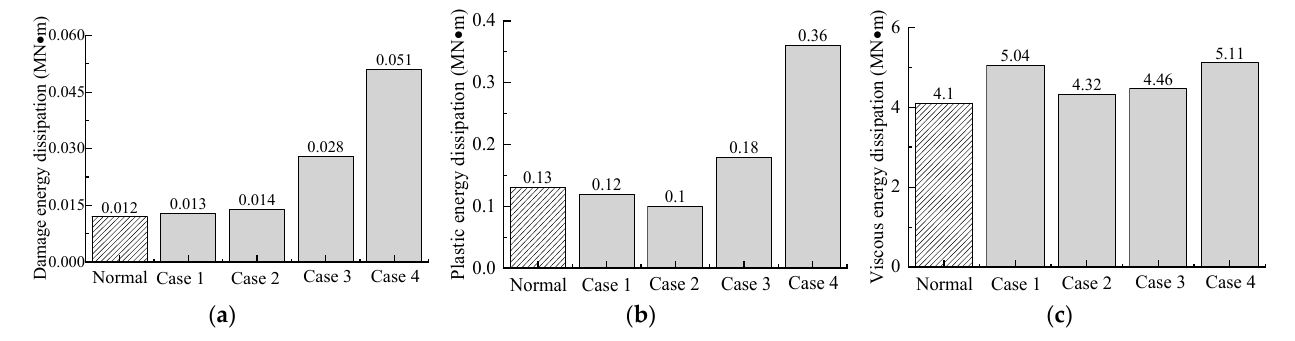
Figure 15. Comparison of the energy dissipation in different cases. ( a ) Damage energy dissipation; ( b ) plastic energy dissipation; ( c ) viscous energy dissipation.